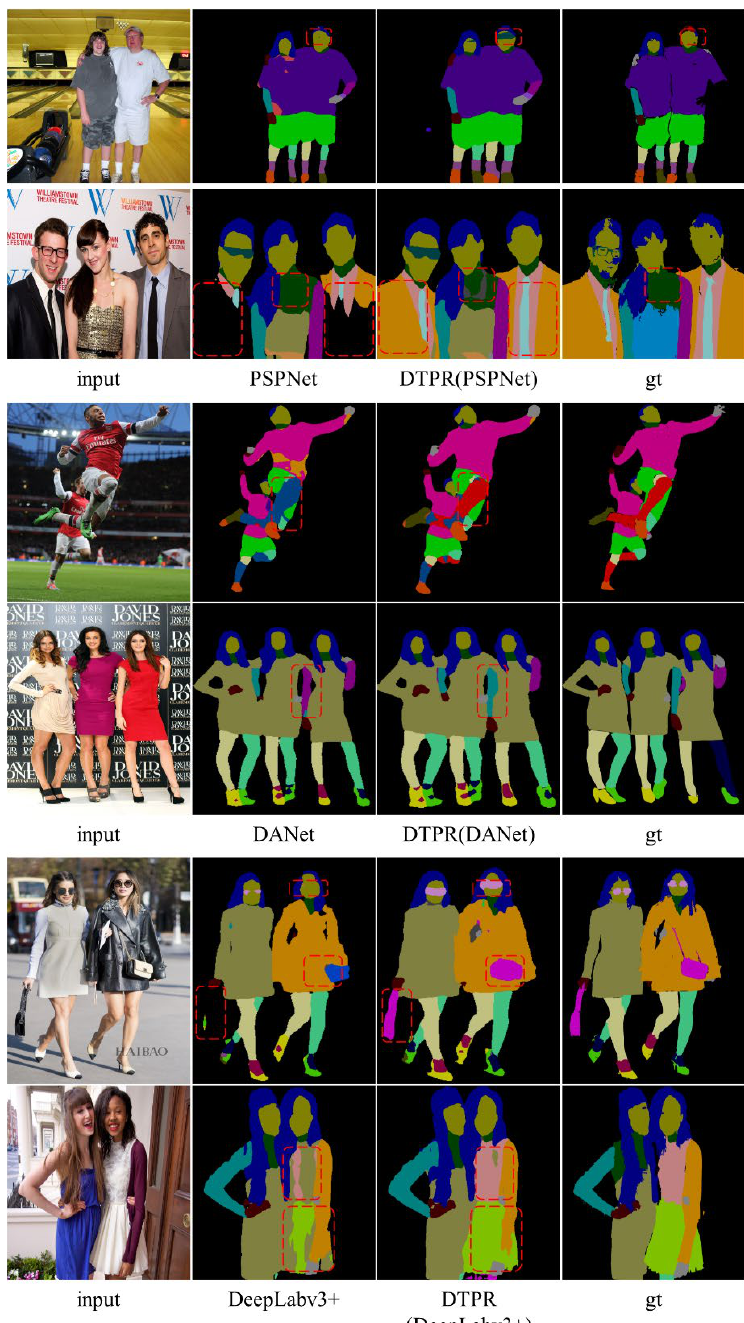
Figure 7. Visual comparison of human parsing results on the MHPv2.0 validation set. Lightweight